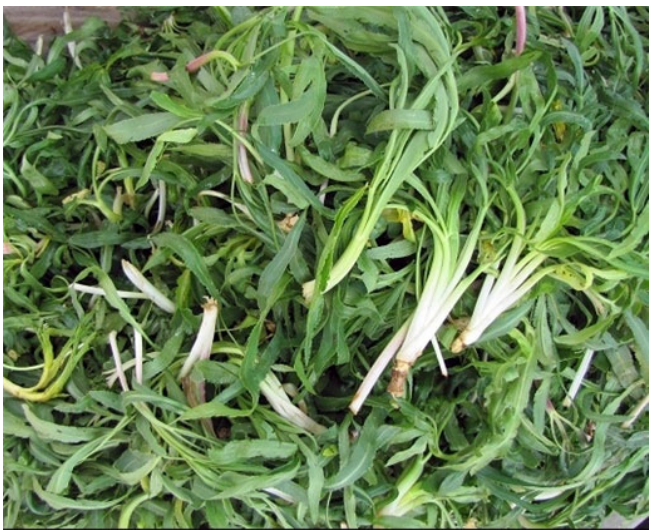
Fig. 1. Image of Tragopogon Fig.1 Image of Tragopogon graminifolius